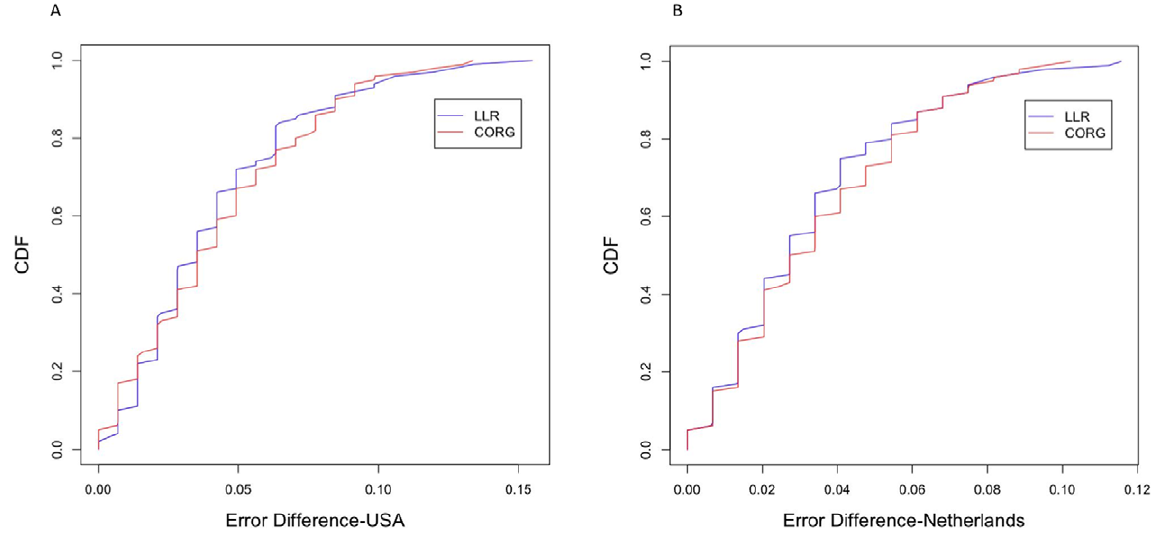
Figure 7. Robustness of the proposed classification scheme. To assess the robustness of the proposed classification scheme, two-fold cross- validation experiments have been performed, where we measured the change in classification error after interchanging the training and test sets. (A) Cumulative distribution of the error difference for the USA dataset. (B) Cumulative distribution of the error difference for the Netherlands dataset.